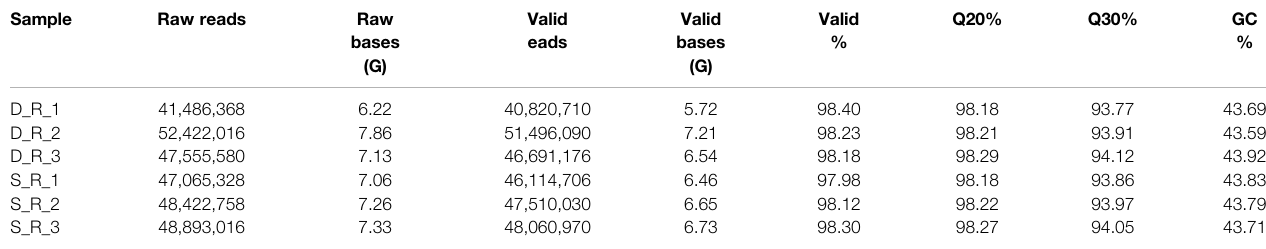
TABLE 1 | The RNA-seq data for these 6 samples.